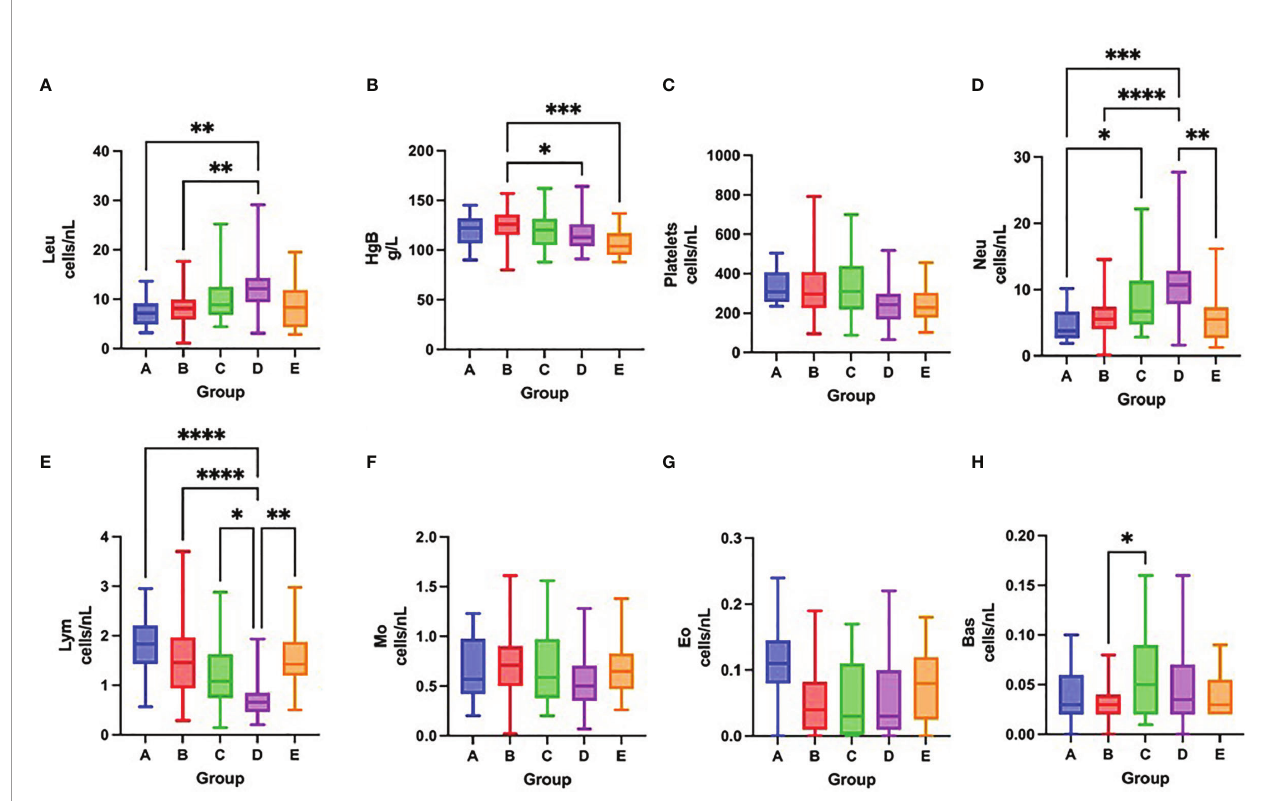
FIGURE 4 | Differences in the total number of leukocytes (A) , concentration of hemoglobin (B) , total number of platelets (C) , neutrophils (D) , lymphocytes (E) , monocytes (F) , eosinophils (G) and basophils (H) among groups A – E after one week of hospitalization, Kruskal-Wallis test. *p < 0.05; **p < 0.01; ***p < 0.001; ****p <